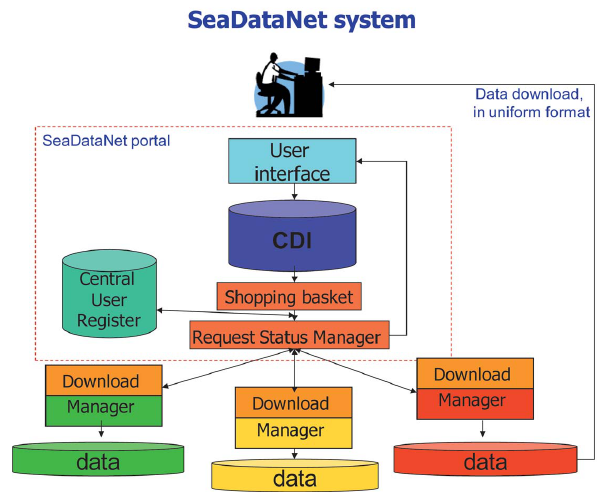
Fig. 2. NODC- i /SeaDataNet data flow. See text for complete